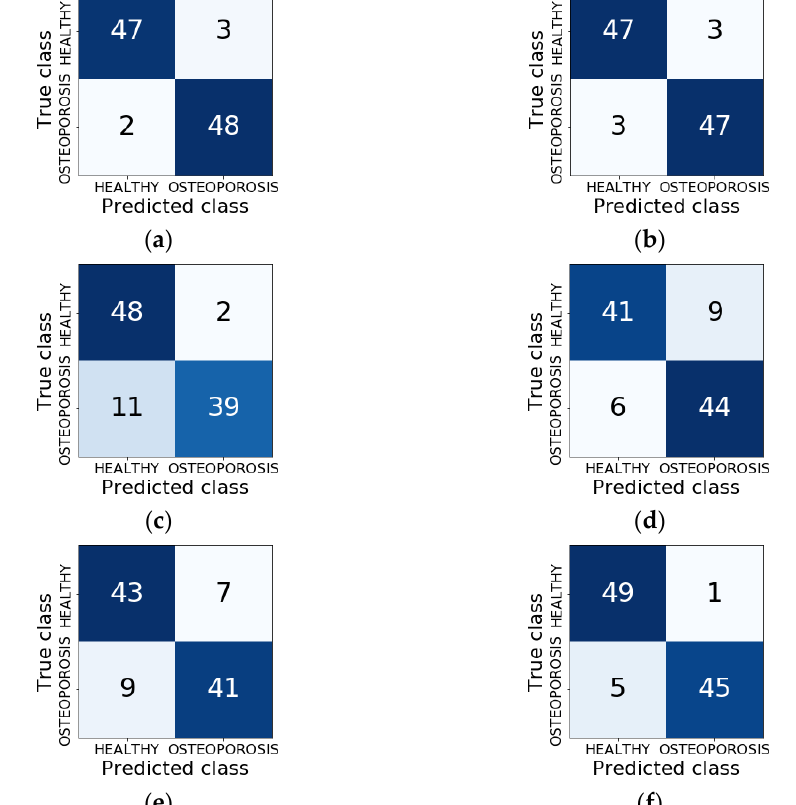
Figure 13. Confusion matrices: ( a ) VGG16; ( b ) VGG19; ( c ) MobileNetV2; ( d ) Xception; ( e ) ResNet50; and ( f ) InceptionResNetV2.